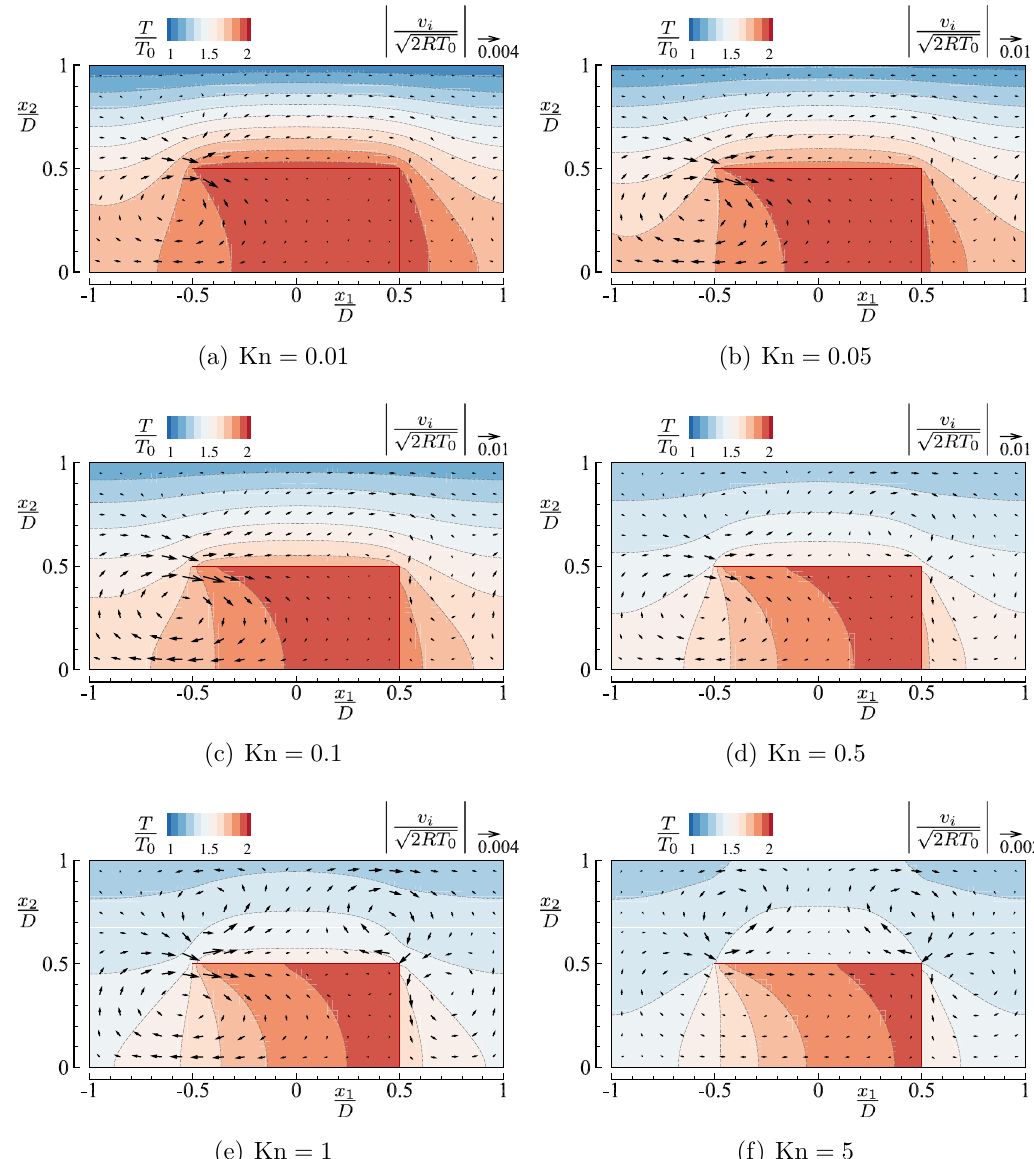
Figure 7. Flow velocity vector ( v 1 , v 2 ) and contour map T in the case of an array of square-U bodies 2 , H / D 2 , and L / D 1 ) for typical Knudsen numbers Kn ( T 1 / T 0 = = = and ( f ) 5. See the caption of Fig.